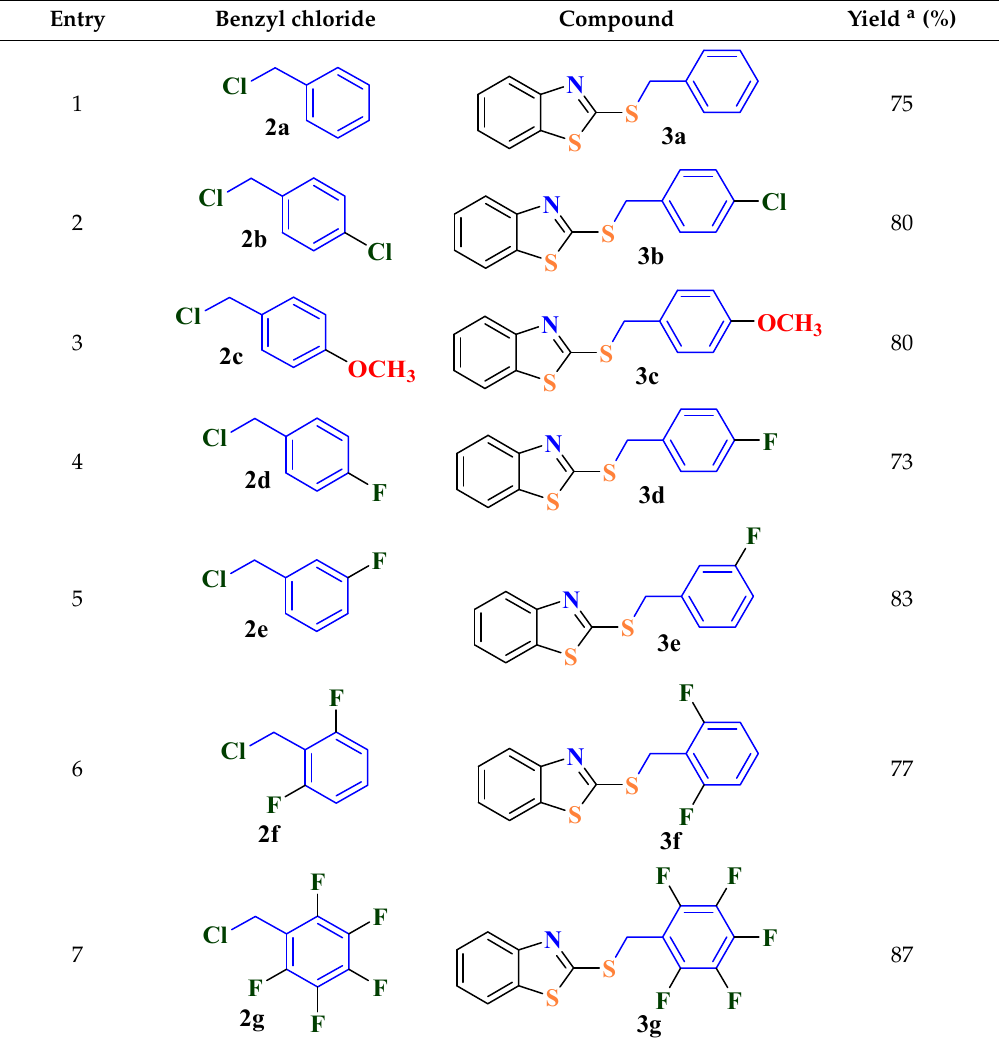
Table 1. Structures and yields of synthesized BTA derivatives.